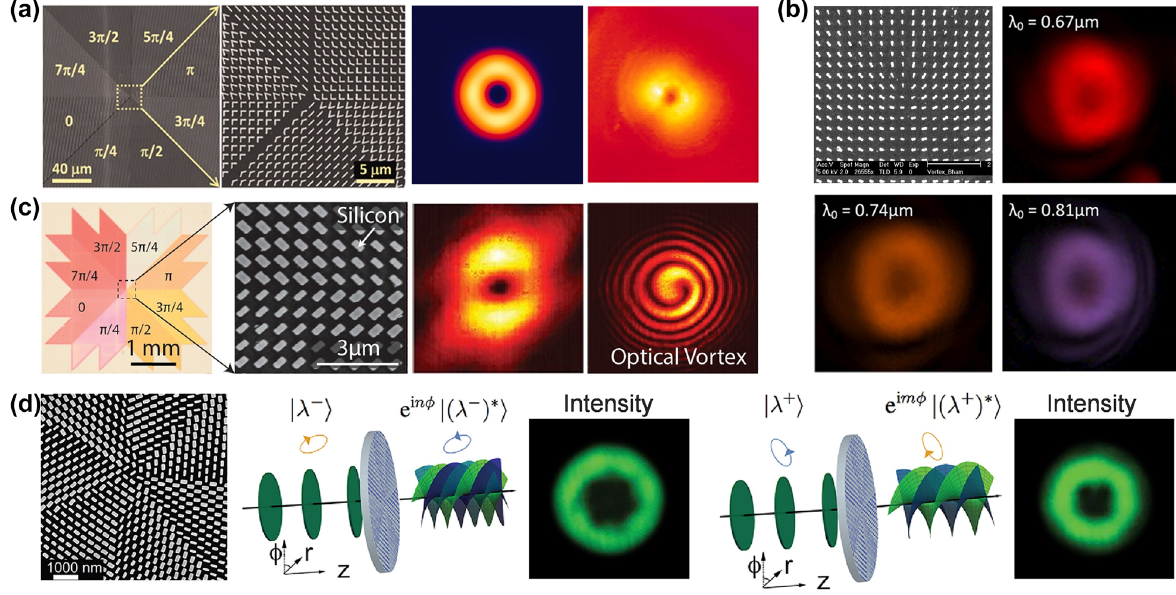
Figure 2: Metasurface for OV generation. (a) Left: Scanning electron microscopy image (SEM) image of a fabricated plasmonic metasurface that generates an optical vortex. The unit cellsarearrangedinsuchawaythatphaseshiftvariesazimuthallyfrom0to2 π .Right:Simulatedandmeasuredfar- fi eldintensitypatternofan OV with l = 1 [11]. (b) Top left: SEM image of the fabricated gold nanopillar based OV generator. Measured intensity distribution of the vortex beampatternsat670nm(topright),740nm(bottomleft),810nm(bottomright)[44].(c)Left:SEMimageofdielectricmetasurfacebasedspiral phase plate. Right: Measured far- fi eld intensity and interference pattern of a OV ( l = 1) [51]. (d) Metasurface based J-plate for arbitrary spin- orbital angular momentum conversion